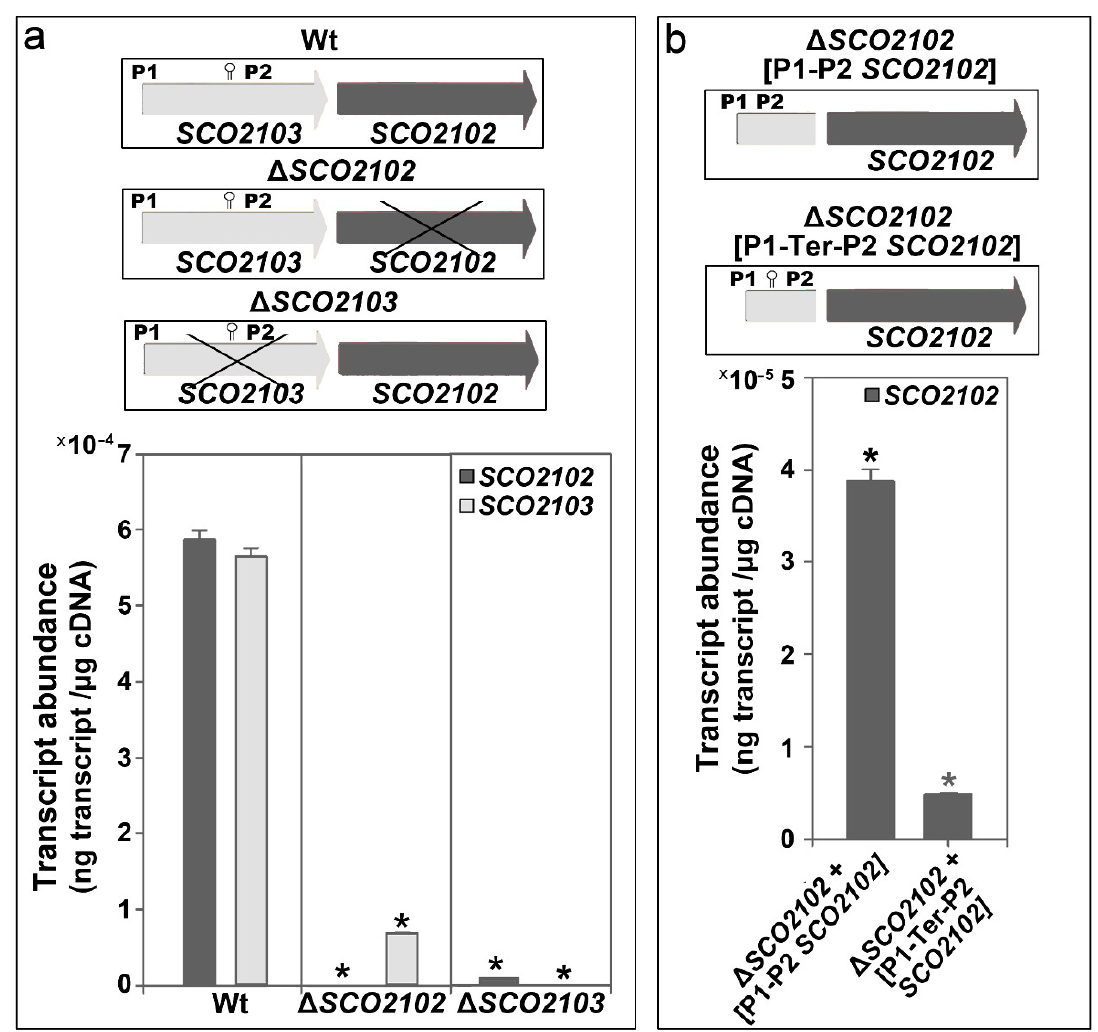
Figure 4. SCO2102/2103 transcript abundances in solid GYM 48 h cultures. ( a ) SCO2102/2103 transcript abundances in the wild-type and the ∆ SCO2102/SCO2103 knockout mutants. ( b ) SCO2102 transcript abundances in the ∆ SCO2102 knockout complemented with the SCO2102 gene controlled by P1 and P2 with and without the conditional transcriptional terminator. Asterisks indicate significant differences compared to the wild-type strain. Three biological replicates were processed.